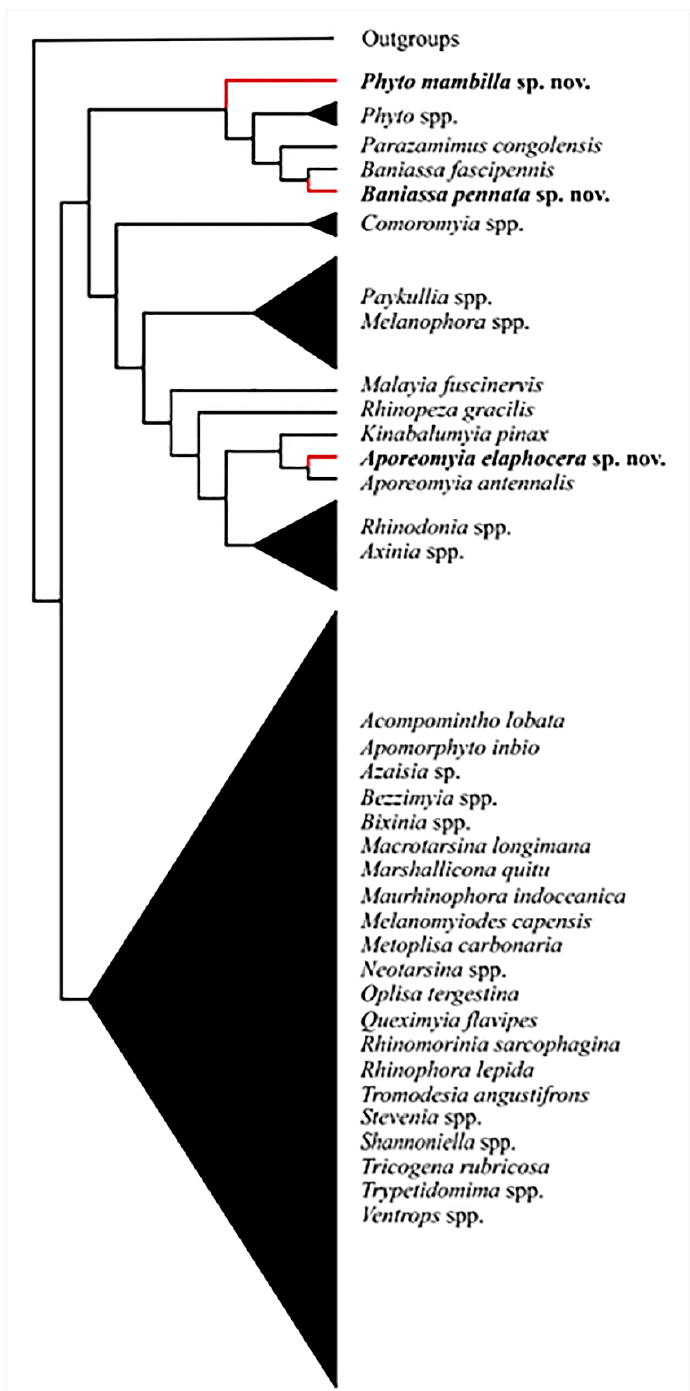
Figure 1. Fittest tree obtained using TNT under implied weighting and a k -value ≥ 4.